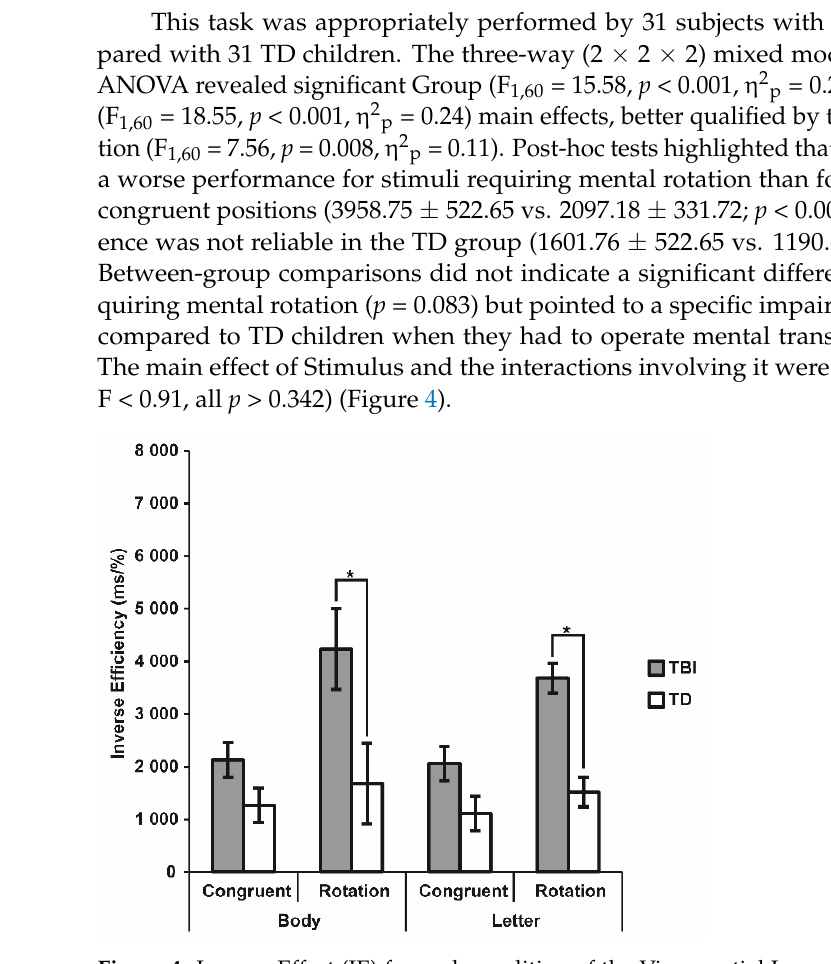
Figure 5. Inverse Effect (IE) for each condition of the Visuospatial Imagery Paradigm for the two clinical groups. Bars indicate the Standard Error of the Mean of measurements in 64 Body and 64 Letter trials for 15 participants with GMD and 16 participants with DAI. 4. Discussion In this study, we investigated whether children and adolescents with TBI may show difficulties in body representation, and which aspects of this complex ability are more deeply affected by damage, more involving the grey matter (group with GMD) or the white matter (group with DAI). Specifically, we administered a visual body recognition